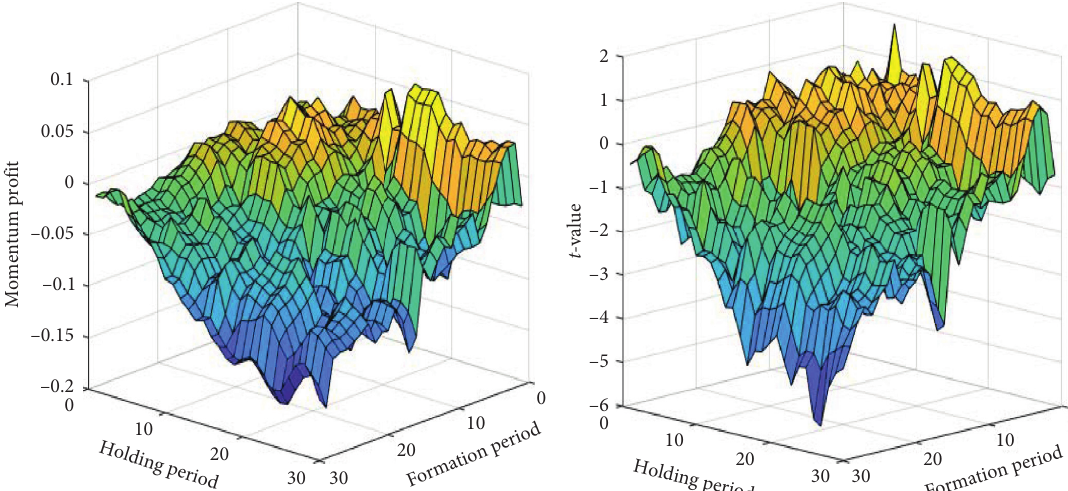
Figure 8: Highest daily relative order imbalance in extensions of the B-share market. This figure shows the momentum profits and t - statistics under the highest daily relative order imbalance in extensions of the B-share market. The formation and holding periods, re- spectively, range from 1 day to 30 days.